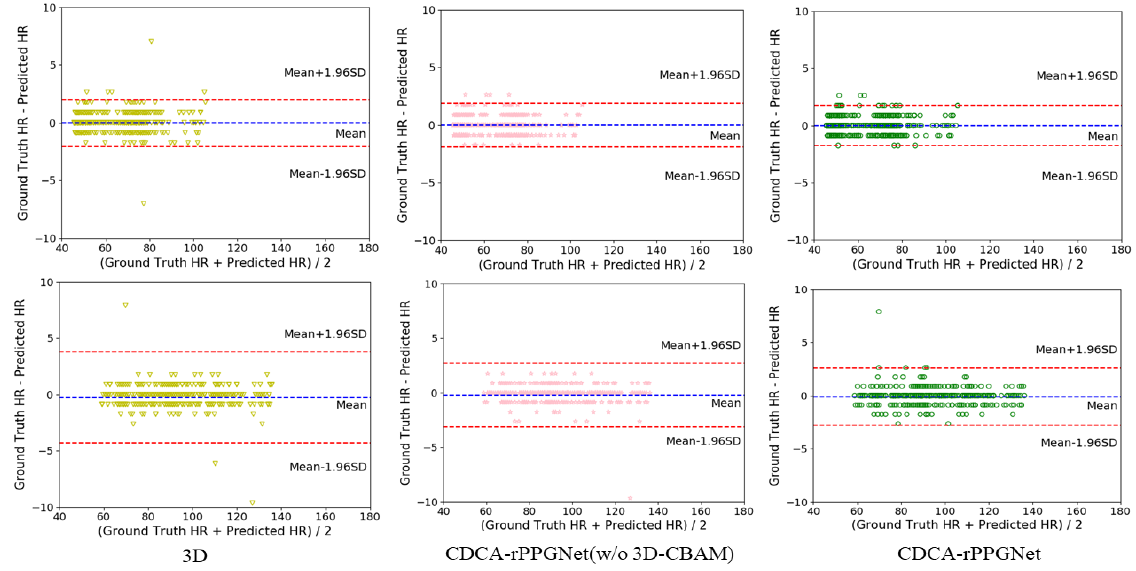
Figure 8. Bland–Altman plots between the estimated HR and the ground truth HR on PURE dataset ( top ) and UBFC dataset ( bottom